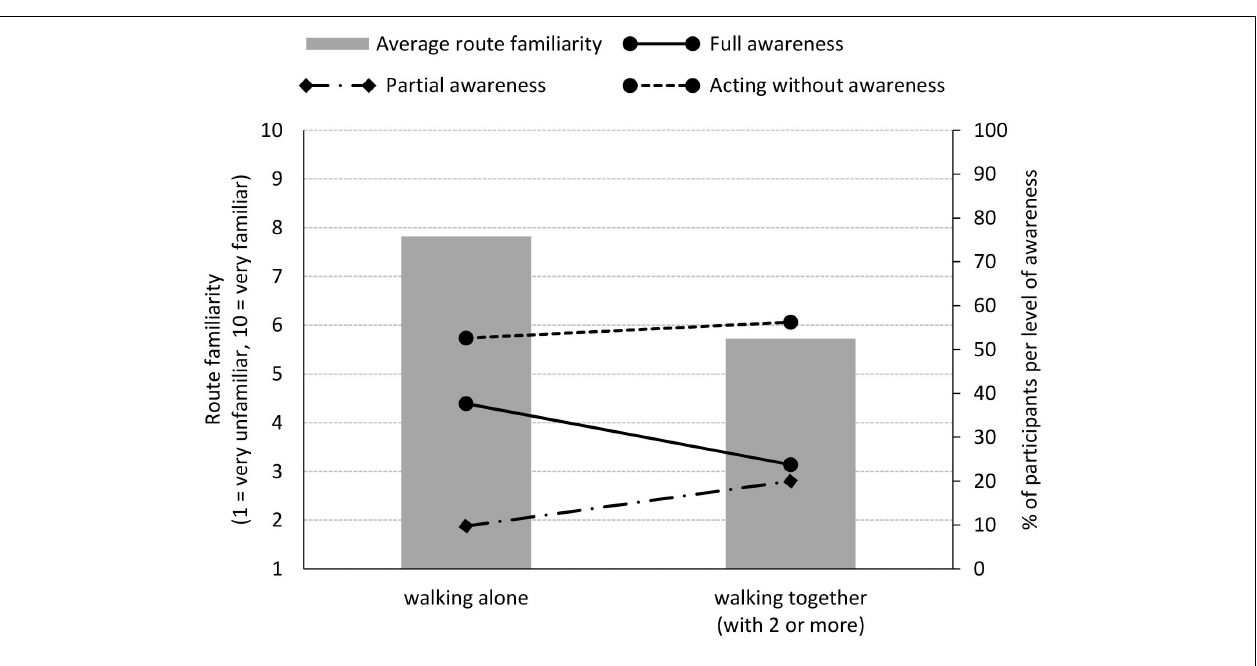
FIGURE 7 | Amount of participants for each level of awareness of the signboard and average route familiarity, for participants walking alone or together (with two or more people). It is significantly more likely that one is partially aware of the signboard rather than fully aware , when walking together compared to walking alone ( p = 0.013). Additionally, pedestrians who were walking together, with two or more people, were significantly more likely to be unfamiliar with the street ( p =